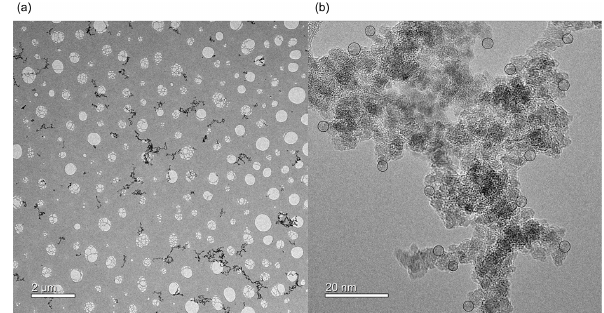
Figure 2. (a) Low-resolution TEM image showing the size range of iron oxide agglomerates (dark grey/black particles) collected on a holey-carbon grid (light grey holes and webbing). (b) High- resolution TEM image showing the primary particles forming an agglomerate. Black circles indicate measured primary spheres used for size